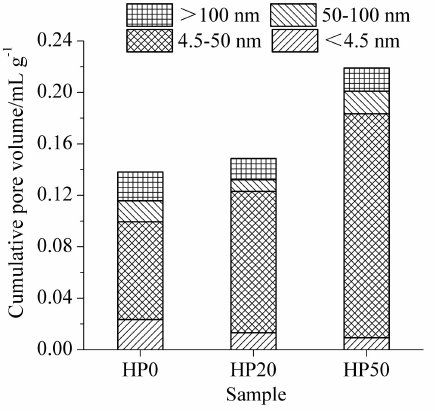
Figure 7. Pore structure of cement-ITP hardened paste cured for 365 days at 60 ◦